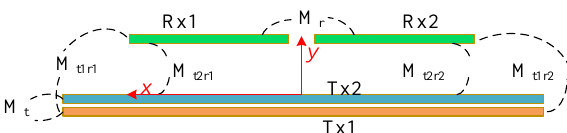
Figure 2. Cross couplings among the coils.